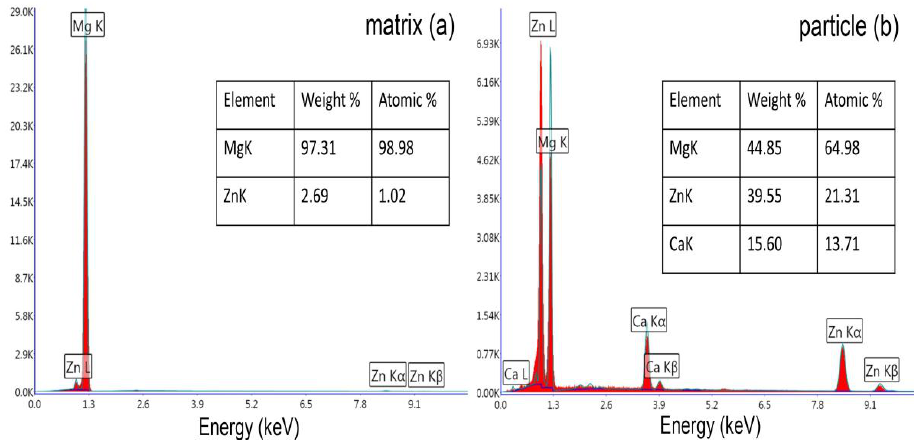
Figure 2. Energy Dispersive X-ray (EDX) spectra obtained from the α-Mg matrix ( a ); and the secondary phase particle ( b ) in the as cast Mg-4Zn-0.16Ca alloy.